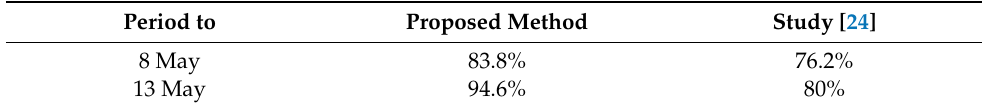
Table 13. Comparison of F1 identification accuracy of rice in 2020.